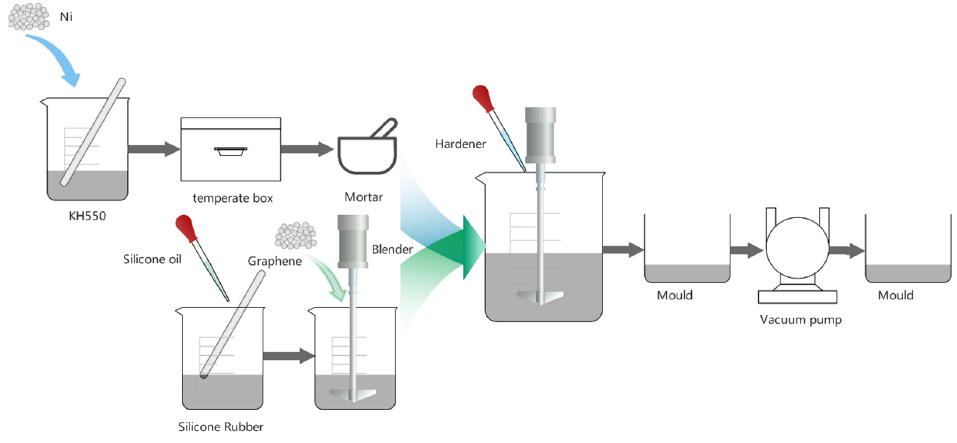
Figure 1. Sensor unit preparation process.